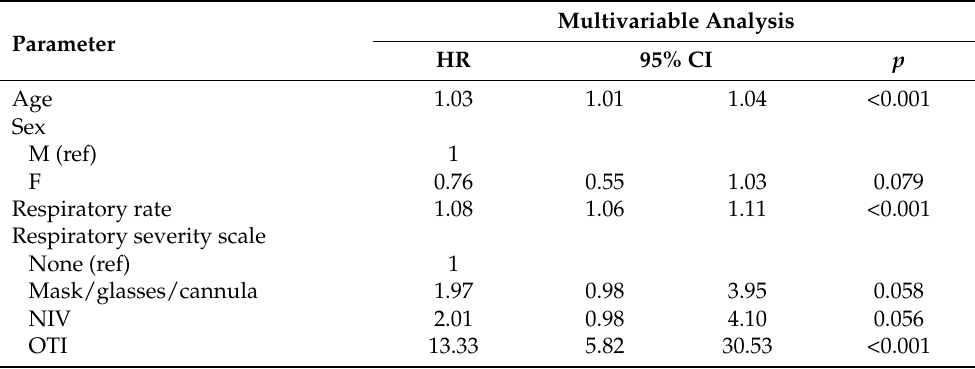
Table 2. Multivariable Cox’s regression